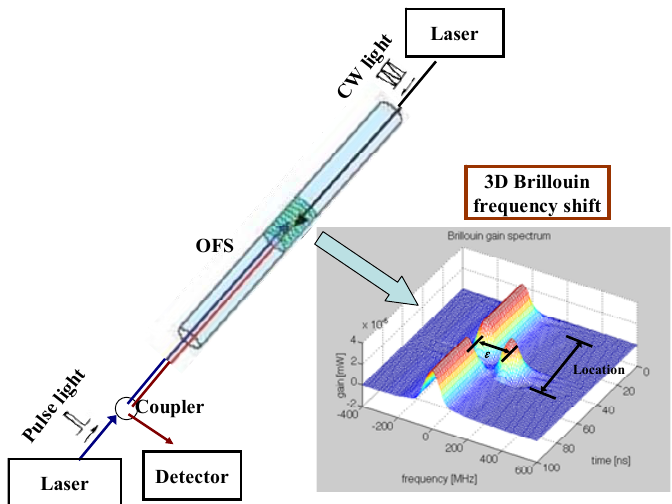
Figure 3. Principle diagram of fiber optic BOTDA